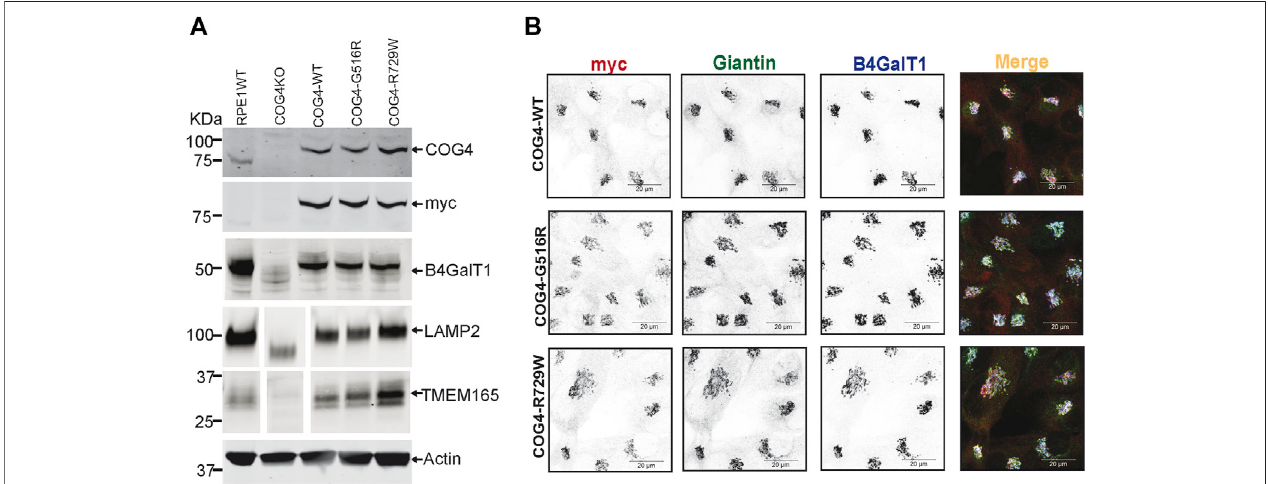
FIGURE2| ExpressionofG516RandR729WmutantproteinsrescuesmajorcellularphenotypesassociatedwithCOG4de fi ciency. (A) WBtodetectCOG4,myc, B4GalT1, Lamp2, Tmem165, and actin in total cellular lysates prepared from RPE1 wild type, COG4 KO, rescued COG4-WT-3myc, COG4-G516-3myc, and COG4- R729W-3myccells.Actinhasbeenusedasaloadingcontrol. (B) AiryscansuperresolutionIFanalysisofRPE1cellsstainedformyc(red),Giantin(green),B4GalT1(blue). The red, green and infrared (blue) channels are presented in inverted black and white mode, whereas the merged view is shown in RGB mode. Scale bars, 20